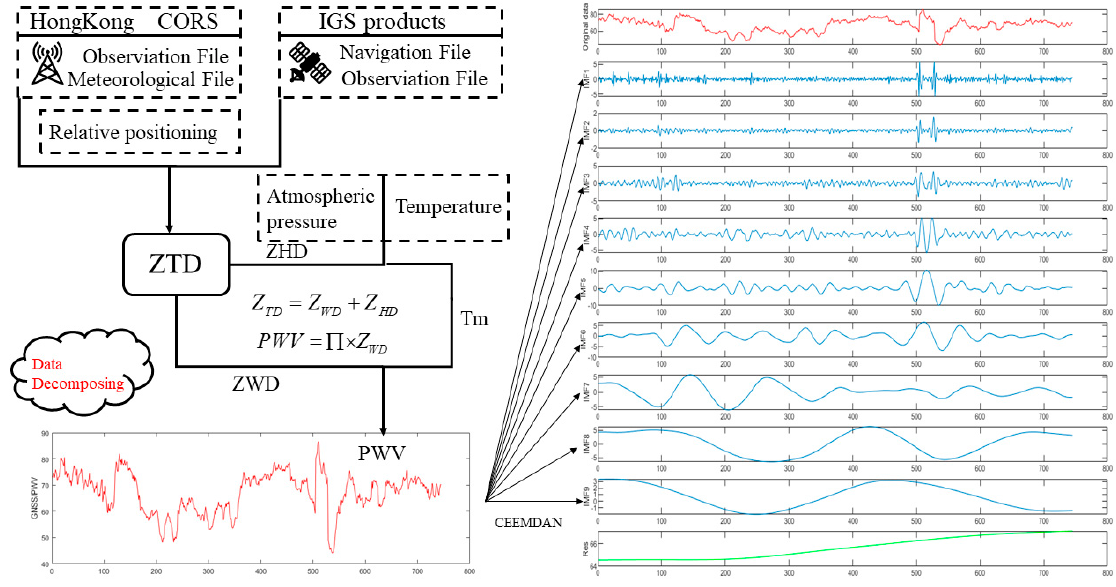
Figure 2. Data preprocessing process.